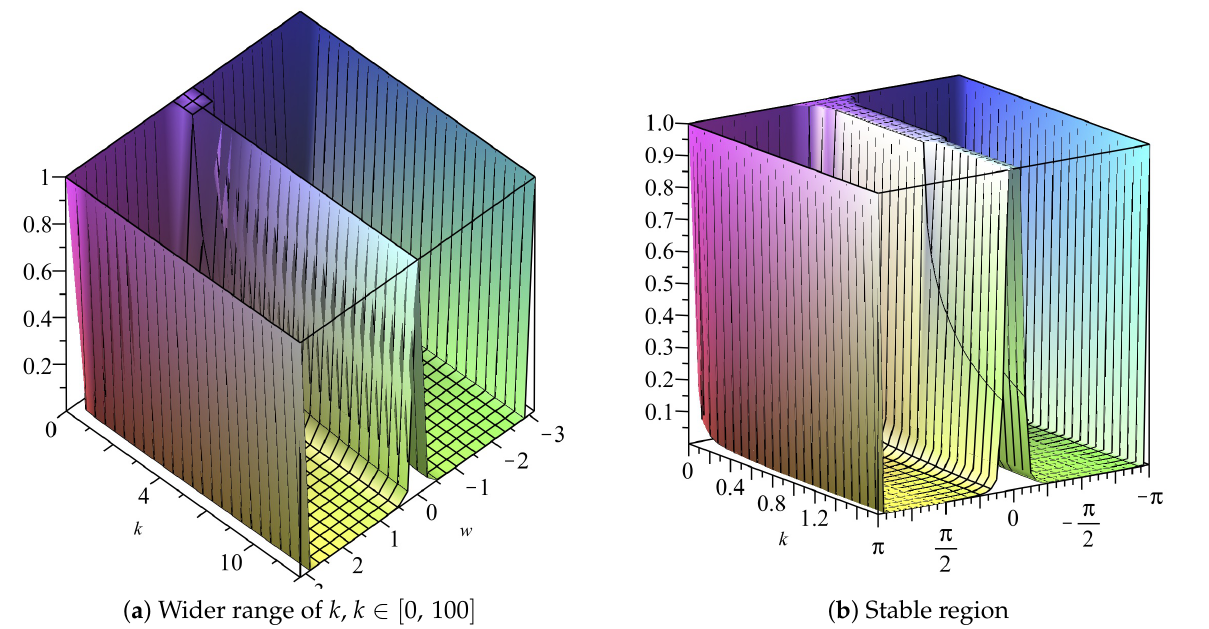
Figure 26. Plot of | ξ 1 | vs. k vs. w of Scheme 3 for Numerical Experiment 2. The spatial step size h = π